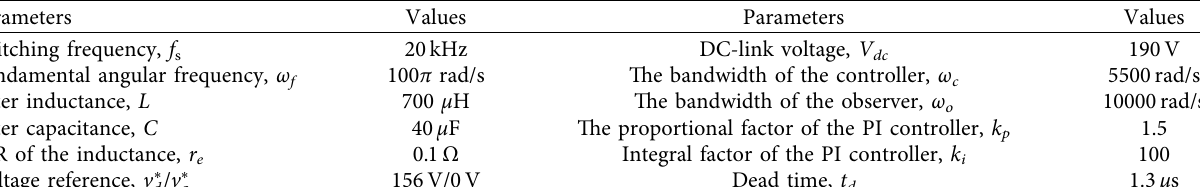
Table 2: Parameters of the inverter system.